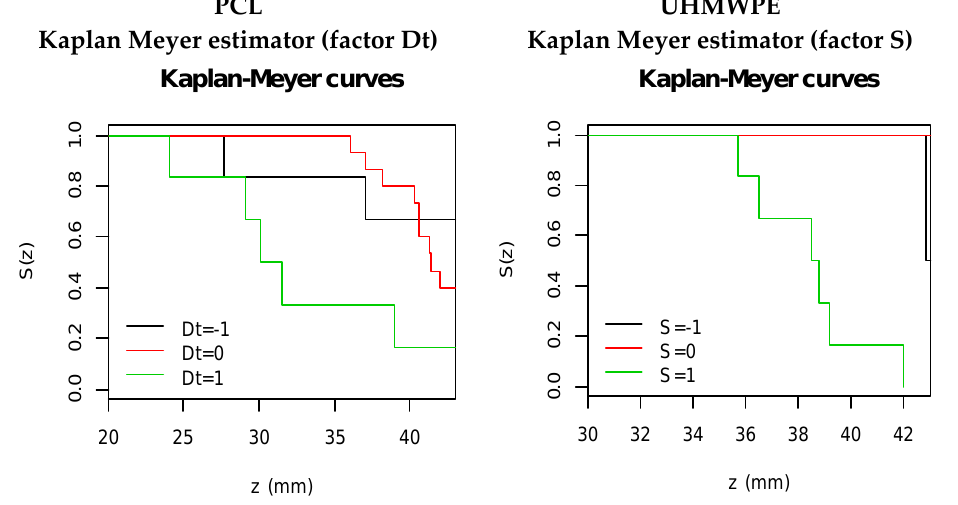
Figure 4. Significant survival curves according to factor levels on PCL and UHMWPE.